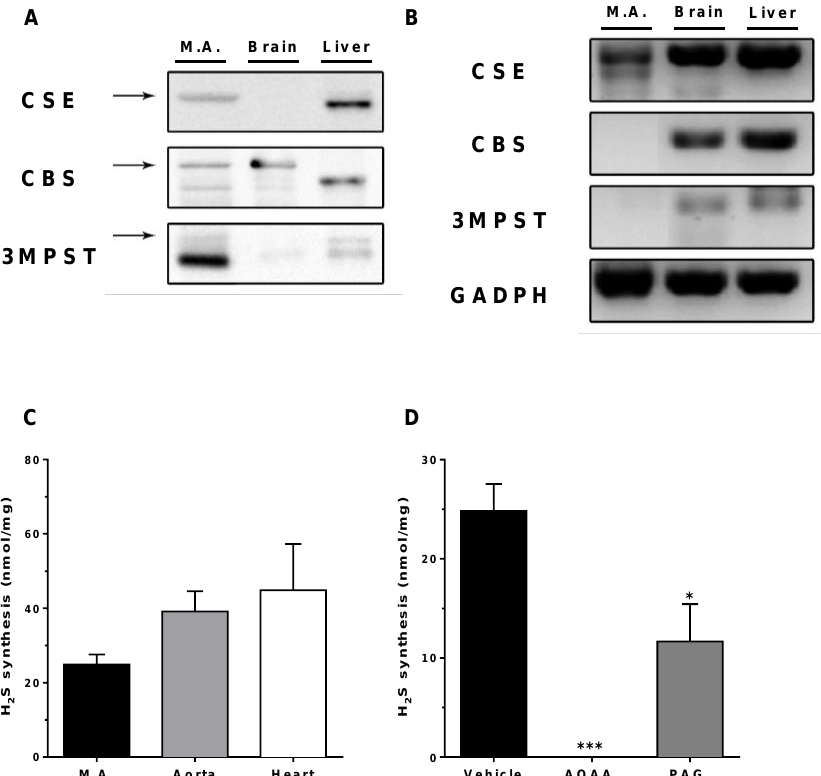
Figure 1. Characterization of the expression and activity of endogenous H 2 S-producing enzymes CSE, CBS, and 3MPST in mouse mesenteric artery. Panels ( A , B ): protein and gene expression, respectively ( n = 4/group). Panel ( C ): In vitro H 2 S production by homogenates of mouse mesenteric arteries, aorta, and heart ( n = 5/group). Panel ( D ): Inhibition of in vitro H 2 S generation by mesenteric artery homogenates by 10 mM PAG or AOAA ( n = 5/group). Data are represented as mean ± S.E.M. * p < 0.05 and *** p < 0.001 vs. Vehicle, as analyzed by one-way ANOVA followed by the Bonferroni post hoc test for multiple comparisons.